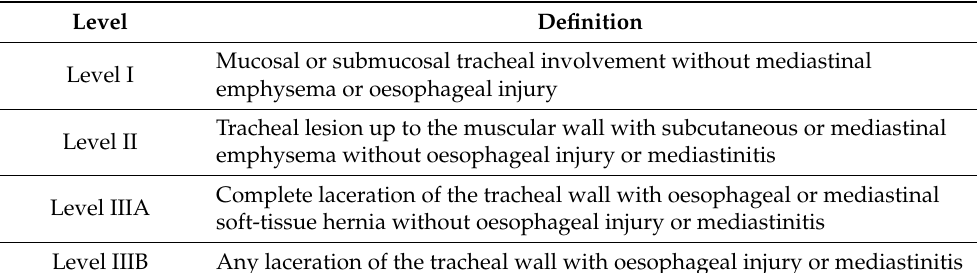
Table 1. Proposal for classification of postintubation tracheal lesion made by Cardillo et al. [7] in